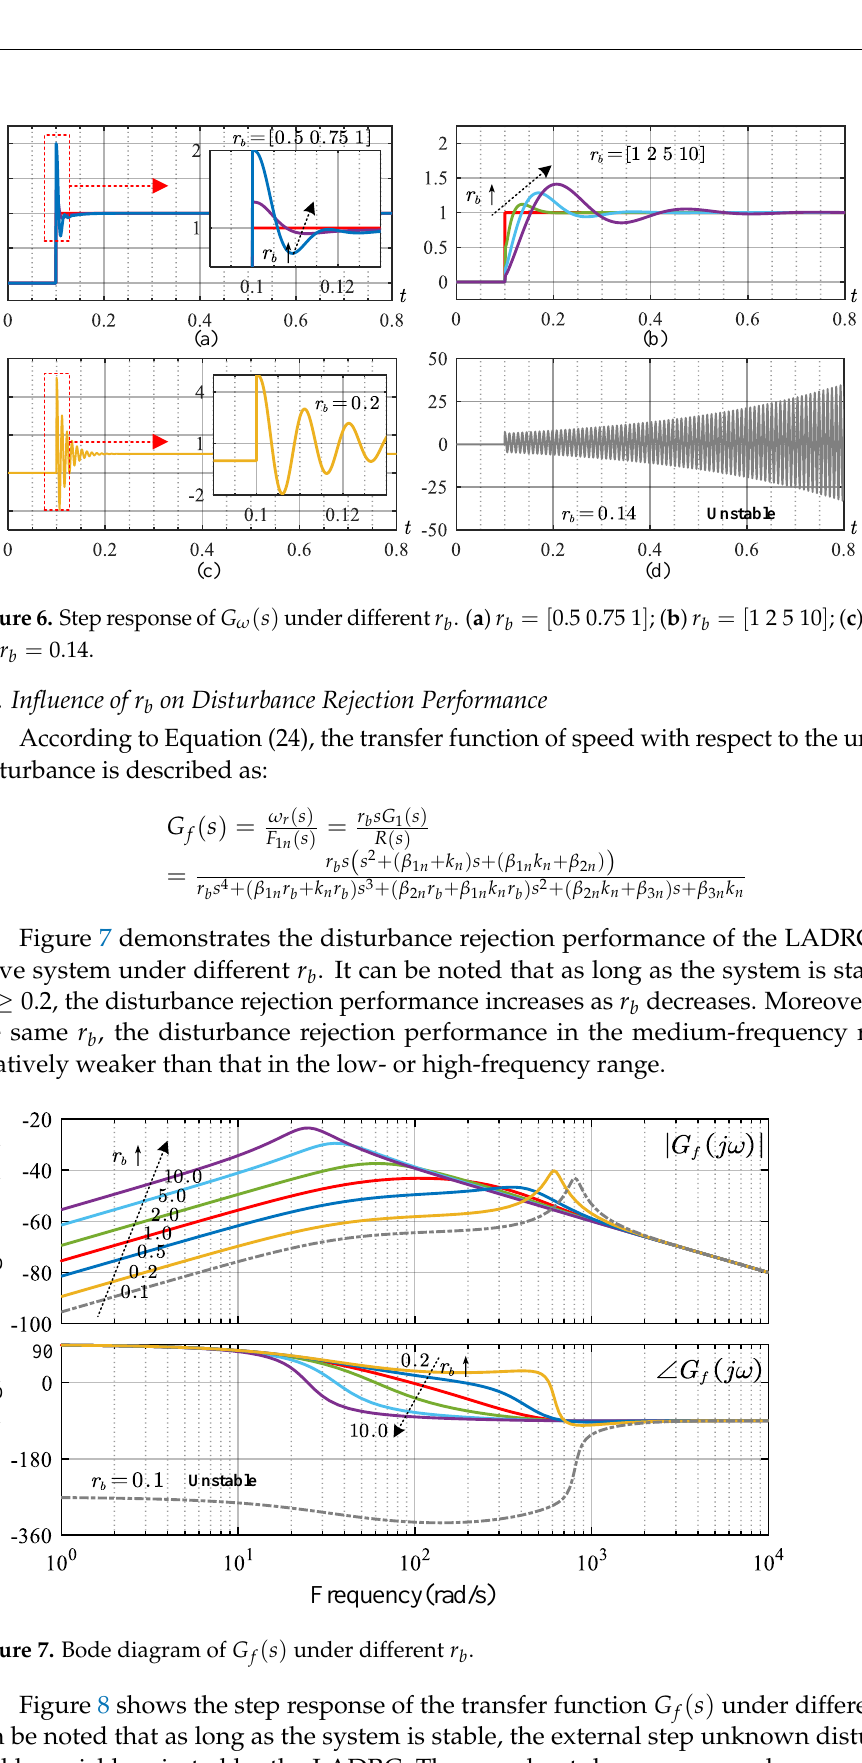
Unstable Figure 8. Step response of